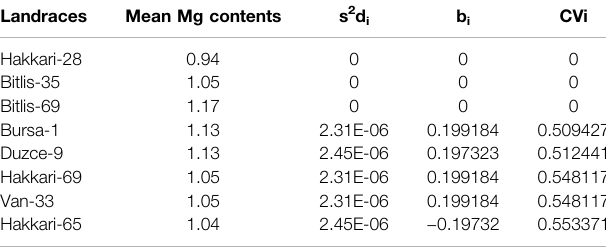
TABLE 3 | The most stable common bean accessions for Mg contents.